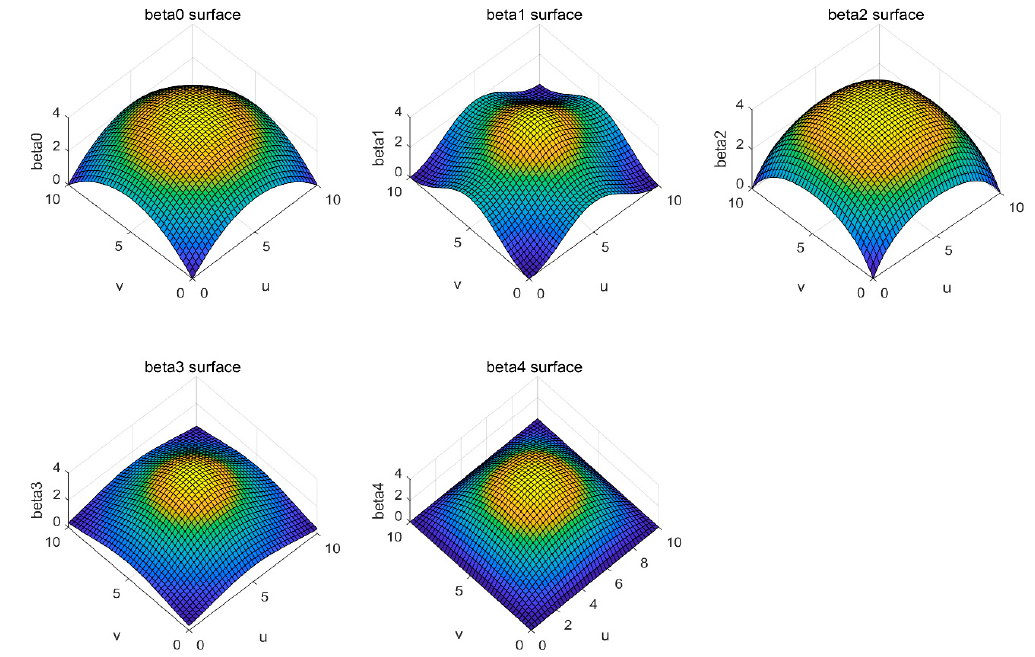
Figure 3. Coe ffi cient ( β 0 , β 1 , β 2 , β 3 and β 4 ) surface. Figure 3. Coefficient ( 𝛽 (cid:2868) , 𝛽 (cid:2869) , 𝛽 (cid:2870) , 𝛽 (cid:2871) and 𝛽 (cid:2872) ) surface.